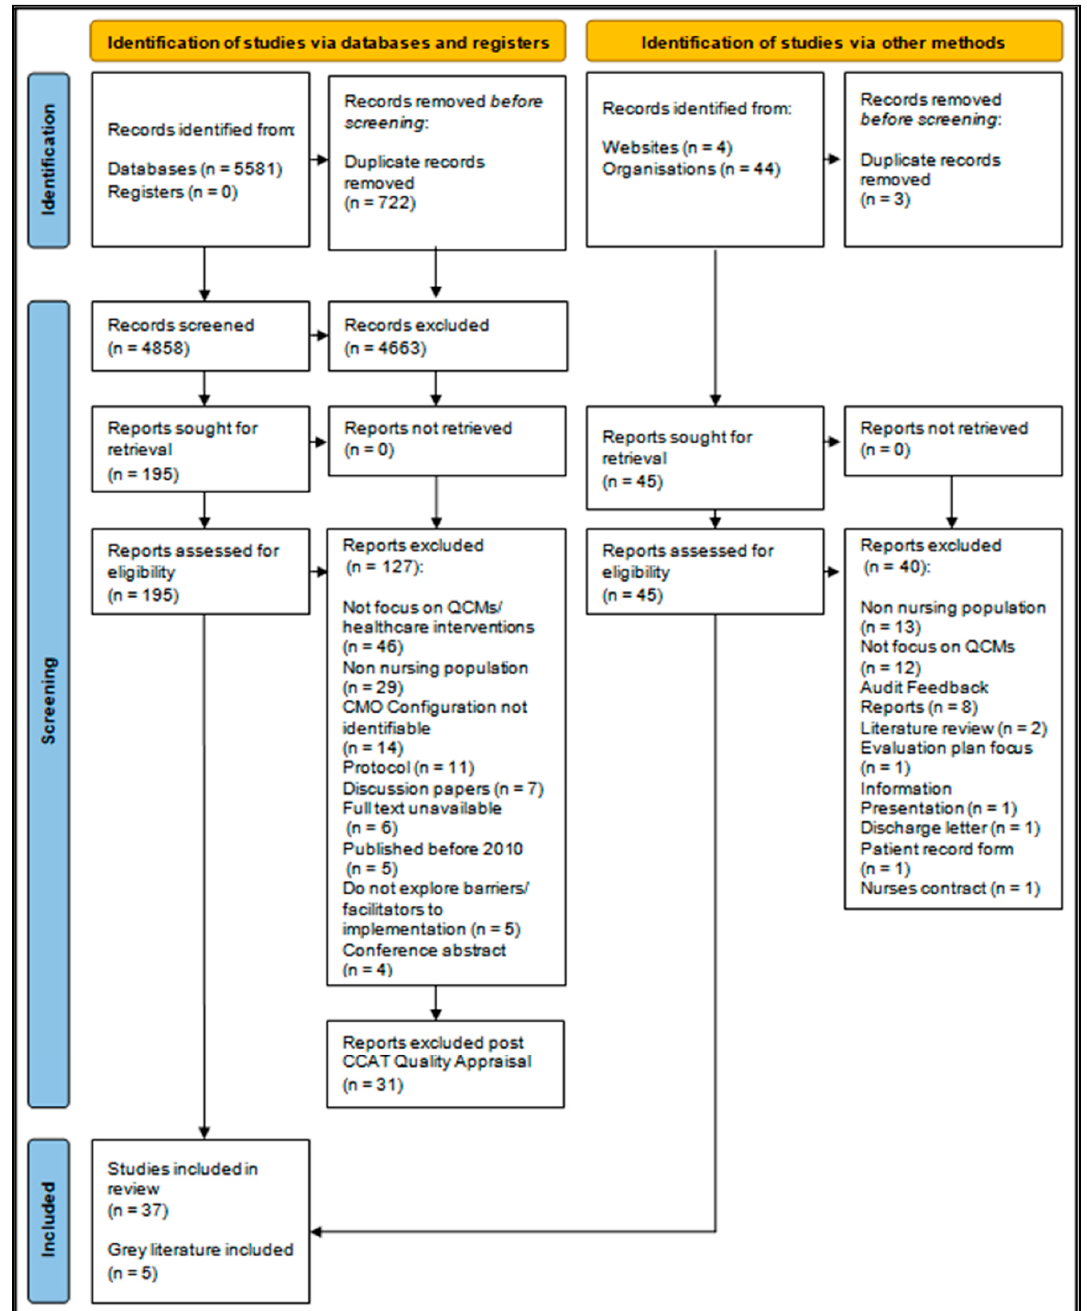
Figure 2. Modified PRISMA diagram.